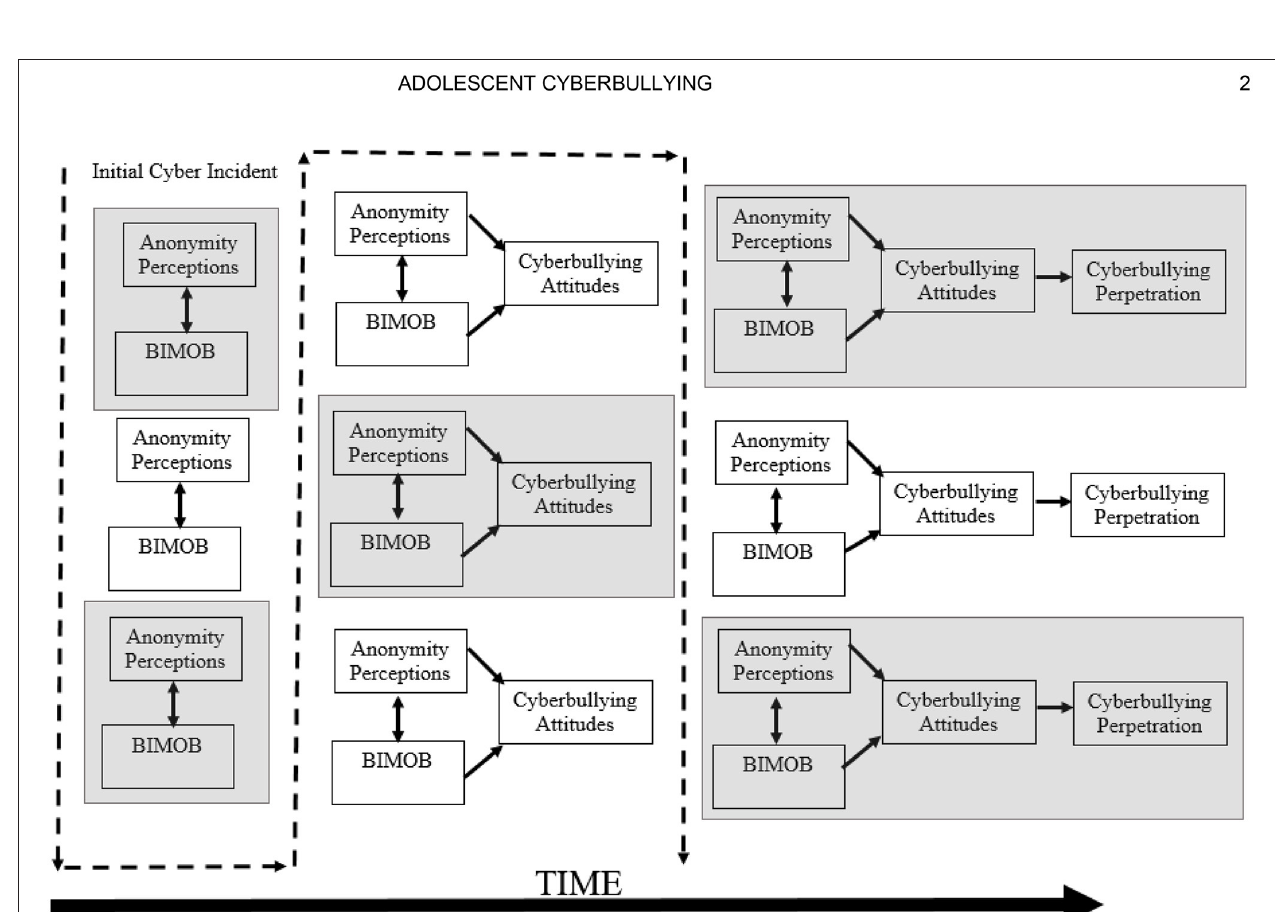
FIGURE 2 | The development of the BGCM with continued experiences over time.